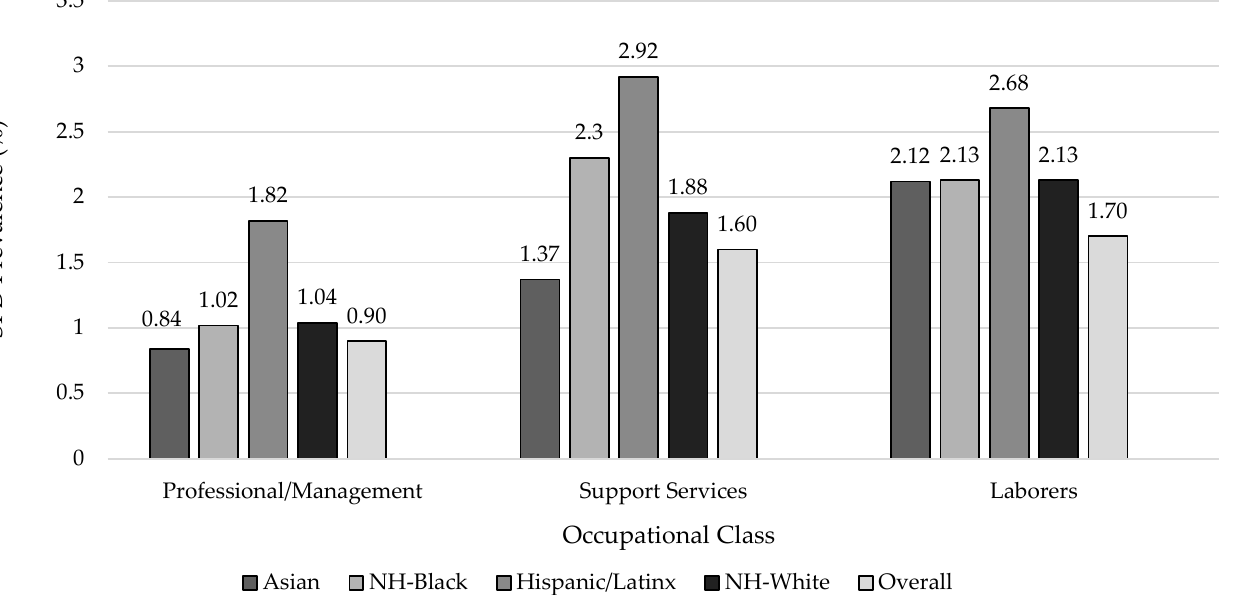
Figure 2. Age-Standardized a Prevalence of Serious Psychological Distress (SPD) by Occupational Class among U.S. Adults Overall and by Race/Ethnicity, National Health Interview Survey, 2004–2018 (N = 245,038). a All estimates are weighted for the survey’s complex sampling design. All estimates except for age are age-standardized to the U.S. 2010 population.